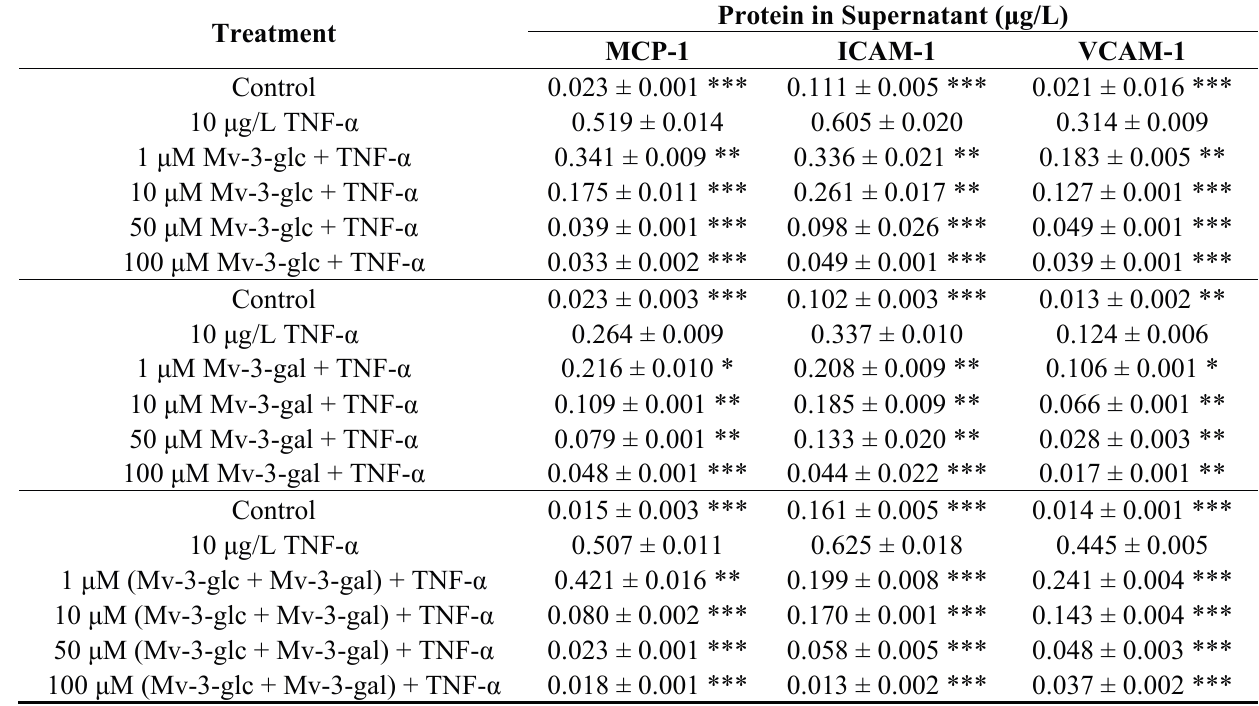
Table 1. Effects of Mv-3-glc and Mv-3-gal on TNF- α -induced MCP-1, ICAM-1, and VCAM-1 in